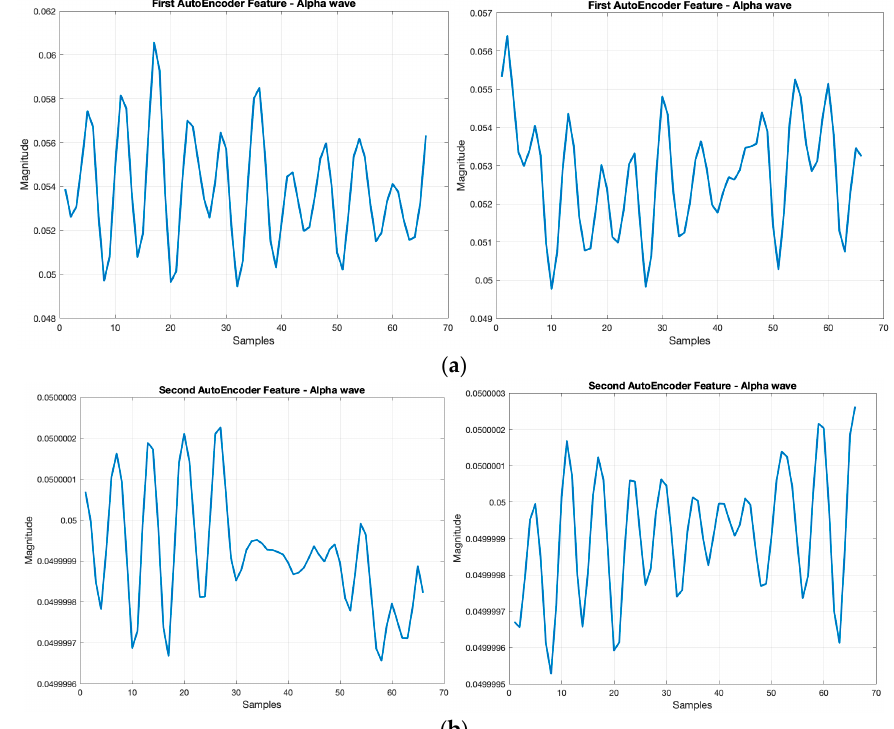
Figure 3. DCT spectral dynamics of the source EEG samples: ( a ) drowsy and ( b ) wakeful; bicubic remapped DCT spectral dynamic: ( c ) drowsy and ( d )